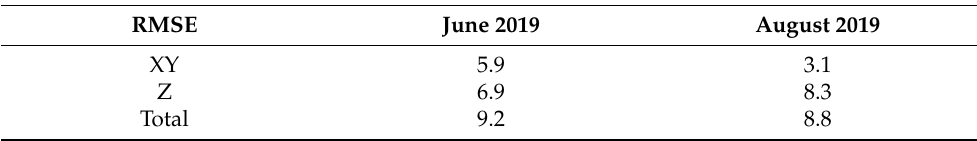
Table 3. RMSE values (in cm) computed from the positional errors between estimated GCP (obtained from SfM processing) and field-measured